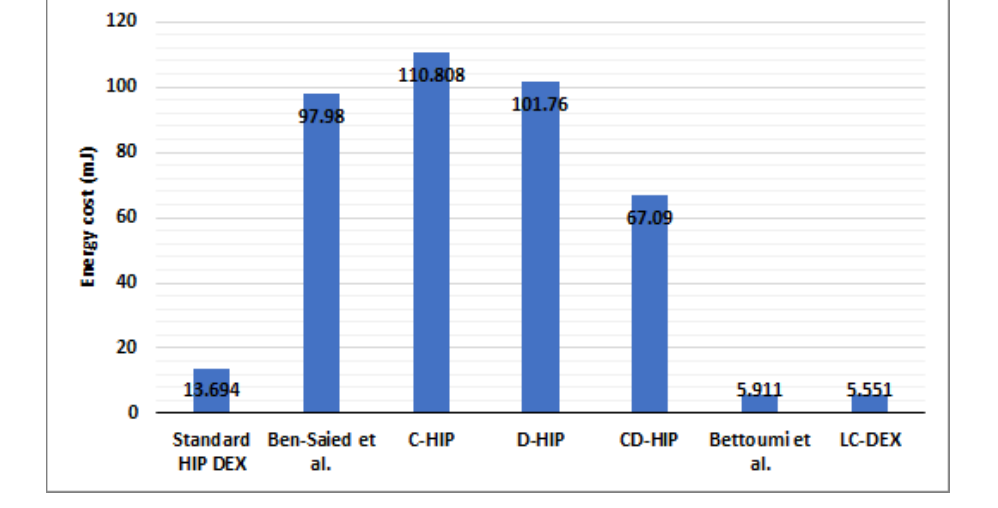
Figure 16. Overall energy